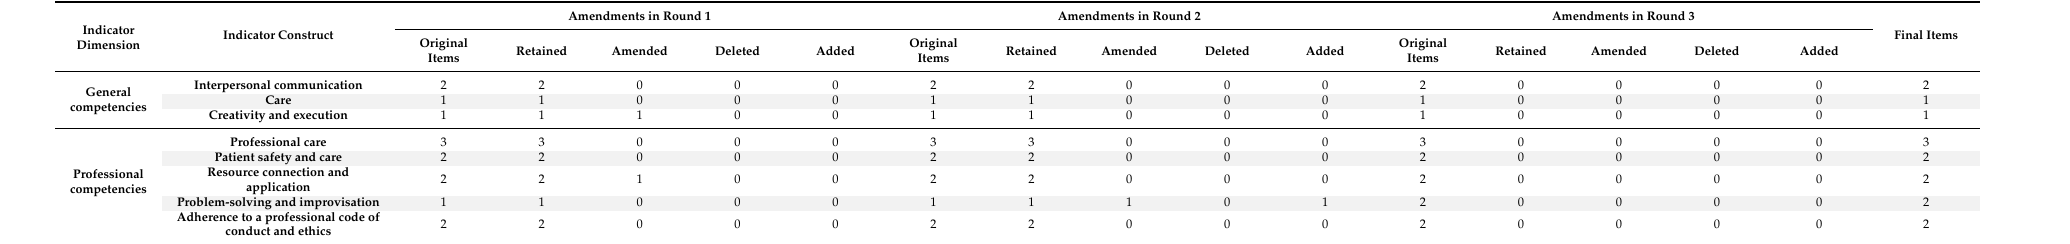
Table 3. Questionnaire amendments of the core competencies in the three-round Delphi questionnaire survey ( n = 10).